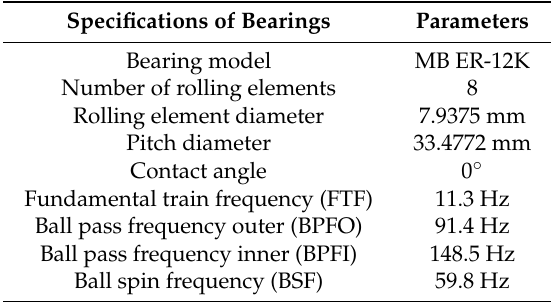
Table 1. Specifications of bearings used in our experiment.